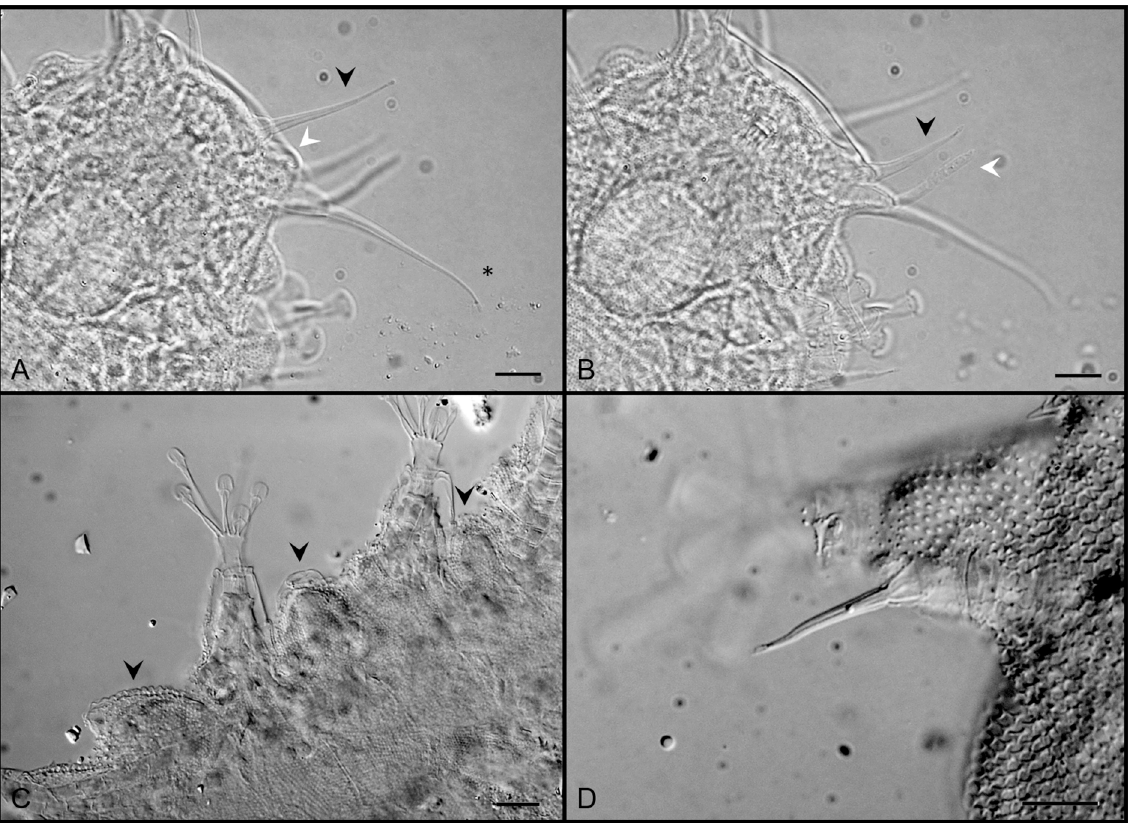
Fig. 5. Batillipes lusitanus sp. nov. A–B , D . Holotype, ♀. A–B . Detail of the head. A . Dorsal view, showing internal cirrus (black arrowhead), lateral cirrus (asterisk), secondary clava (white arrowhead). B . Ventral view, showing primary clava (white arrowhead), external cirrus (black arrowhead). C . Detail of body lateral projections of a paratype (slide C.IX-46) (black arrowheads); D . Detail of leg sensory organ on leg IV. Scale bars = 10